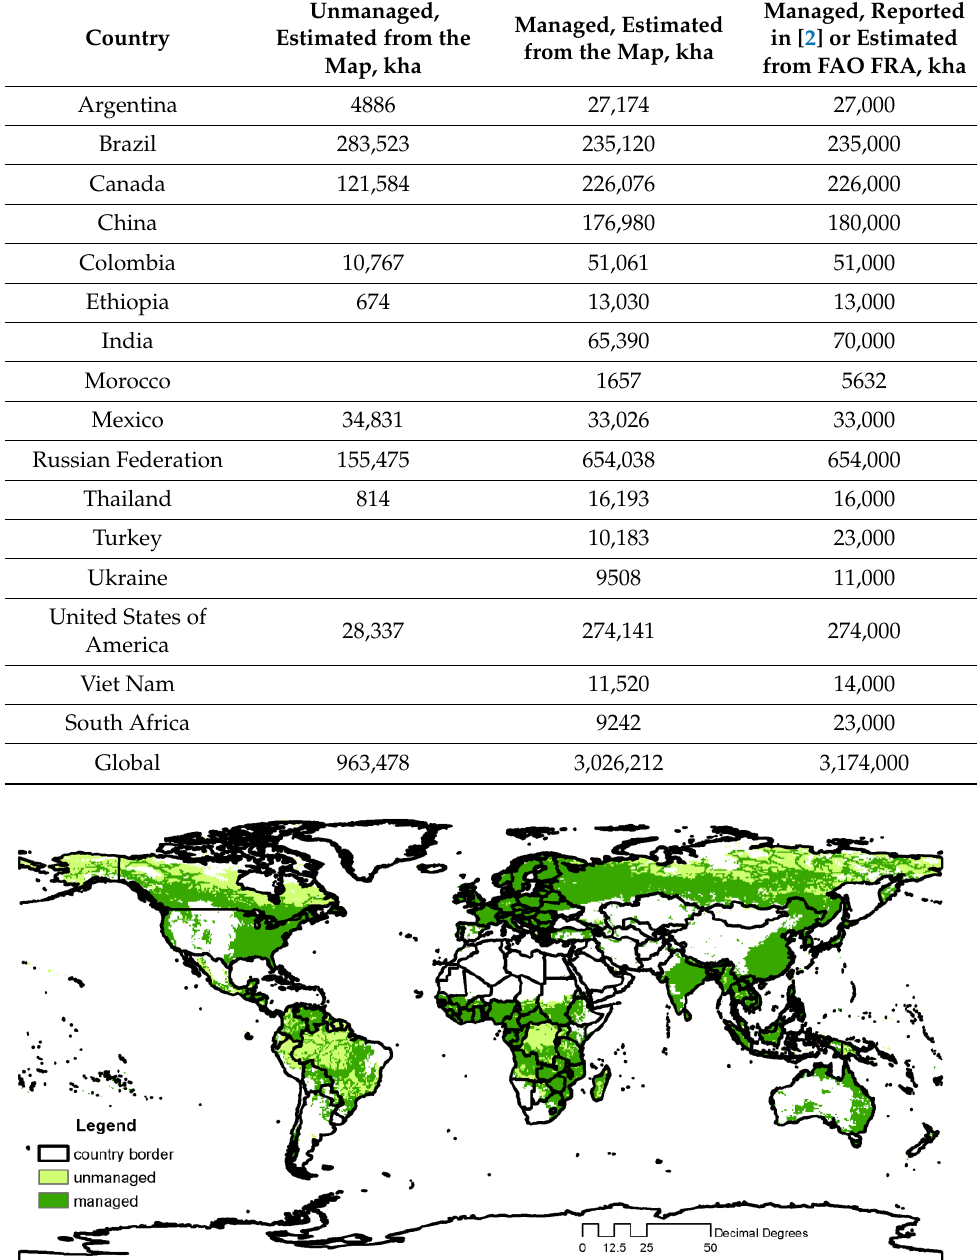
Figure 1. A map of managed forest area consistent with the countries’ reports of GHG emissions to UNFCCC.